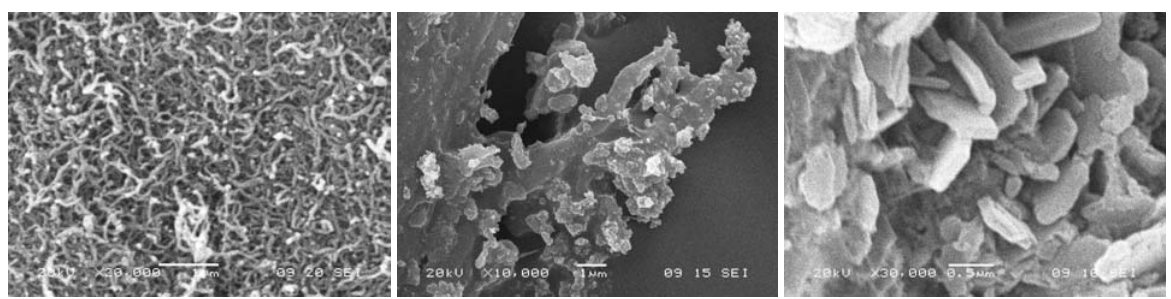
Figure 2. The images of SEM (a) CNT. (b) La-TiO2. (c)